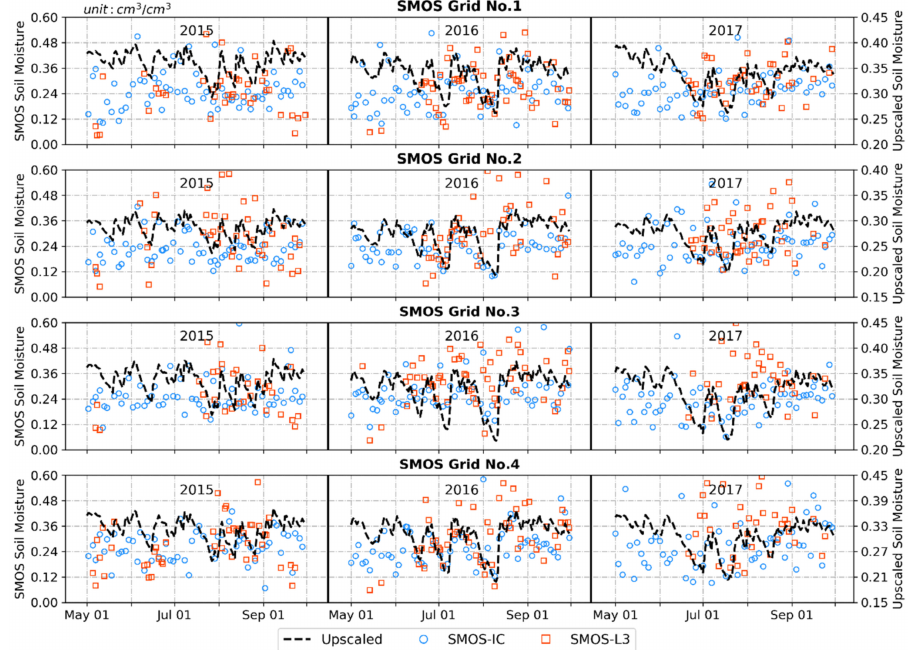
Figure 10. Temporal comparisons between the upscaled SM and SMOS products at the 25 km